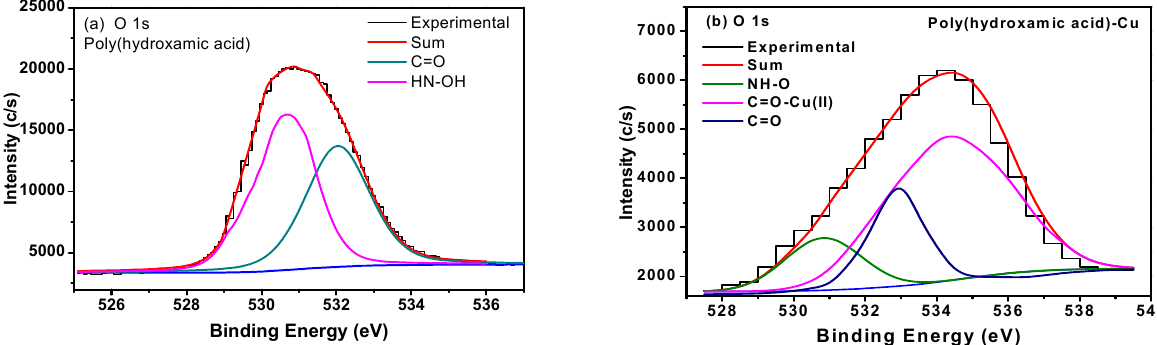
1s in the O-NH and C=O groups, respectively (Figure 6a). However, after complexation of ligand with copper ions, the BEs of O 1s for O-NH increased from 530.5 to 531.0 eV and the O 1s for C=O was split into two peaks with increased BEs of 533.0 and 534.6 eV (Figure 6b). The peak appearing at BEs of 533.0 eV corresponds to O 1s for C=O and BEs of 534.6 belongs to the oxygen atom bonded with Cu (C=O-Cu) (Figure 6b). eV belongs to the oxygen atom bonded with Cu (C=O-Cu) (Figure 6b).